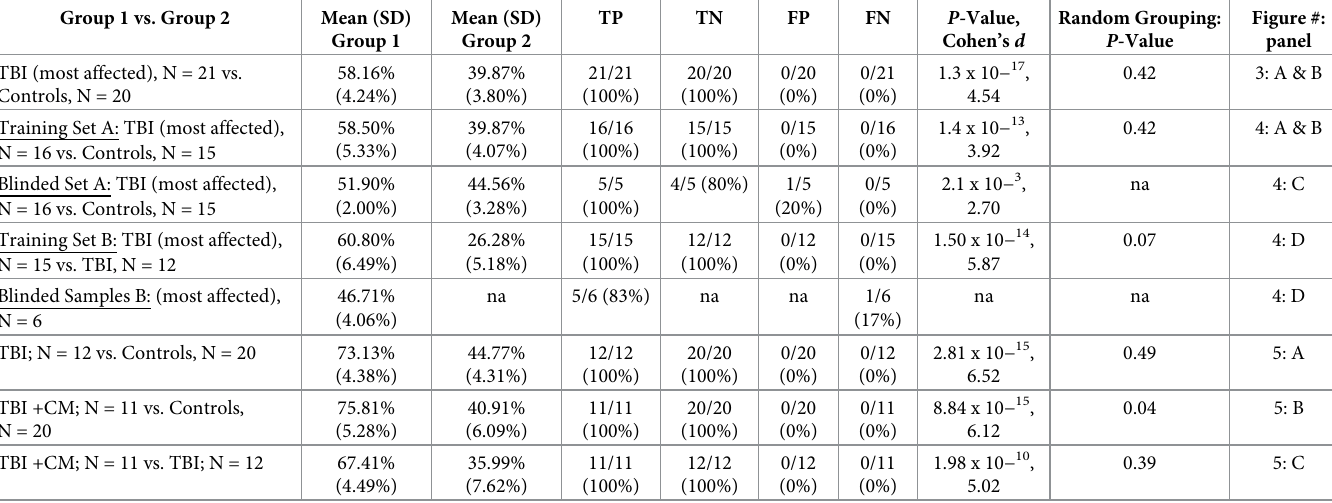
Table 2. LOOCV serum mass profiling test metrics. Group 1 vs. Group 2 Figure #: